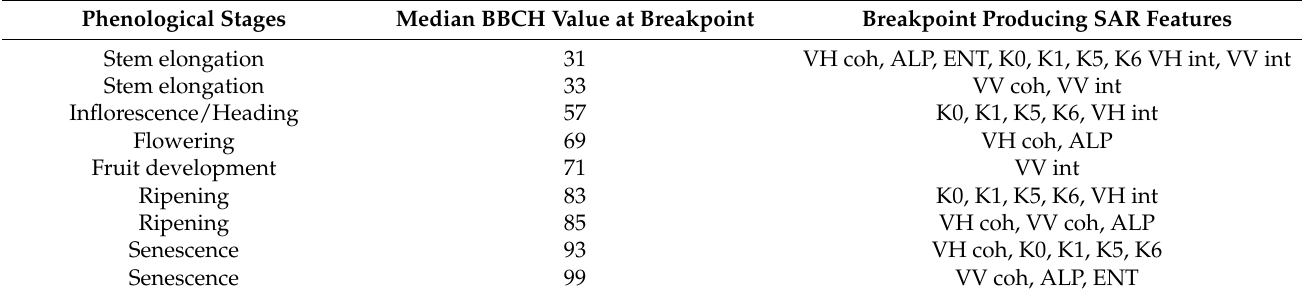
Table 3. Median BBCH values and phenological stages of breakpoints derived from Sentinel-1 (S-1) features in wheat fields. Phenological Stages